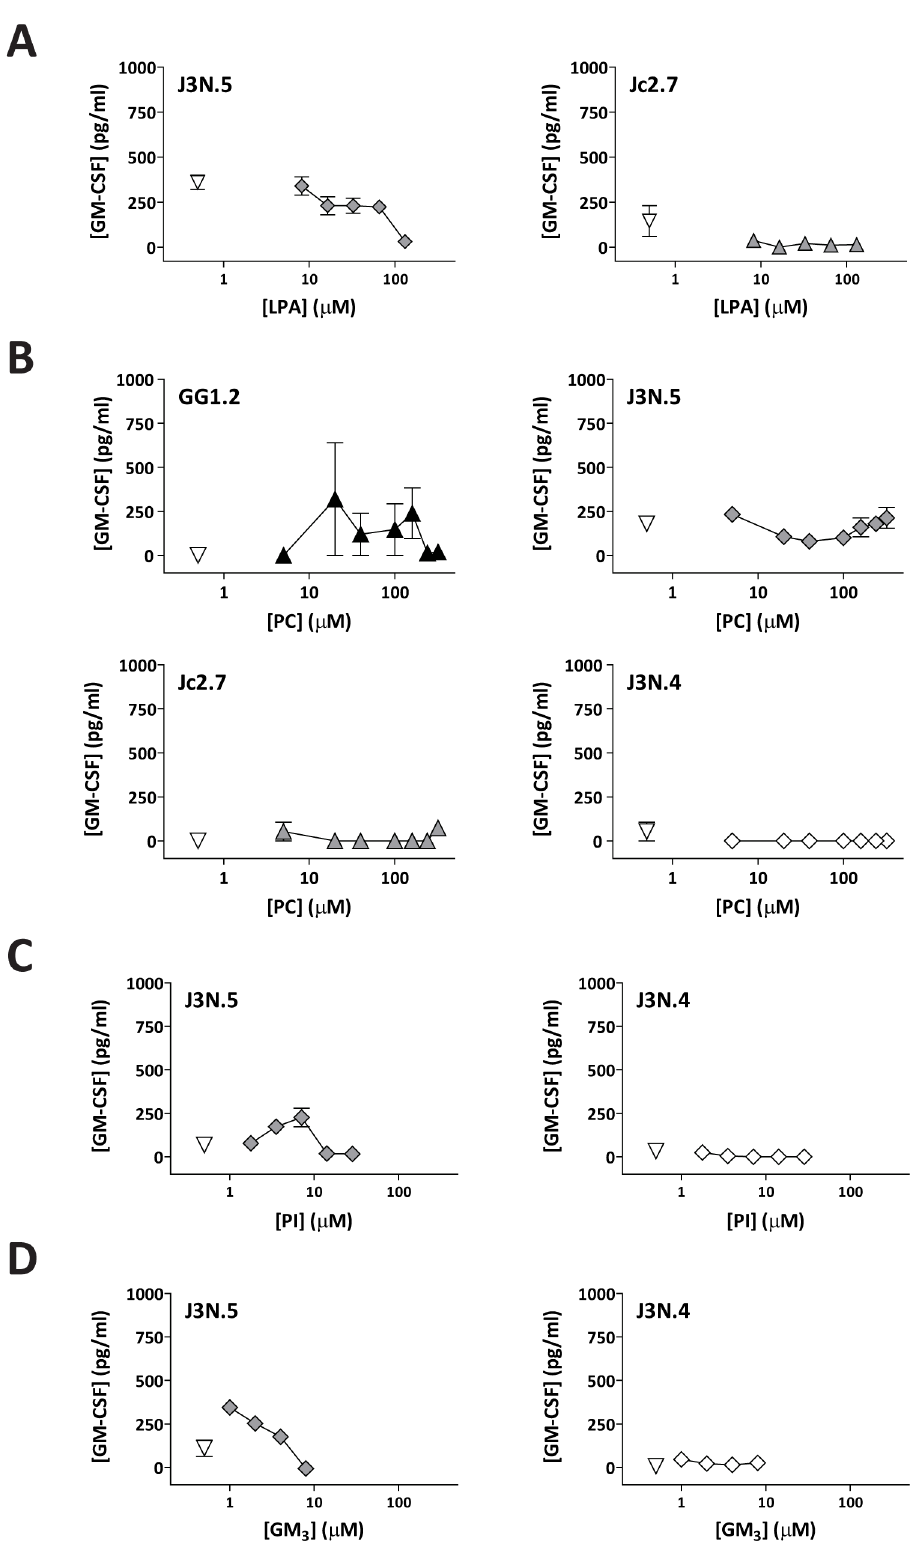
Figure 2. NKT cells show little or no response to other cellular lipids. (A) Representative examples of NKT cell clone responses to immobilized CD1d molecules pulsed with synthetic C18:1 LPA; (B) synthetic C18:1/C18:1 PC, (C) synthetic C18:1/C18:1 PI, and (D) purified ganglioside GM3. The plots show the means and standard deviations of three to four replicates.